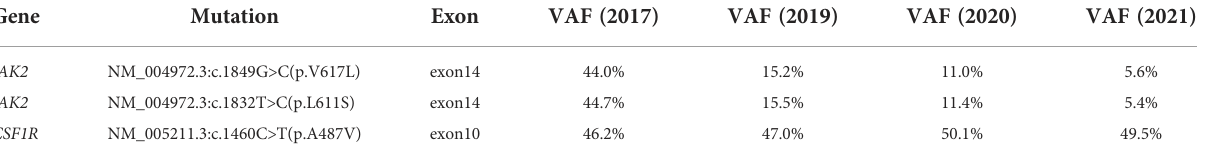
TABLE 2 Next-generation sequencing screening result of this